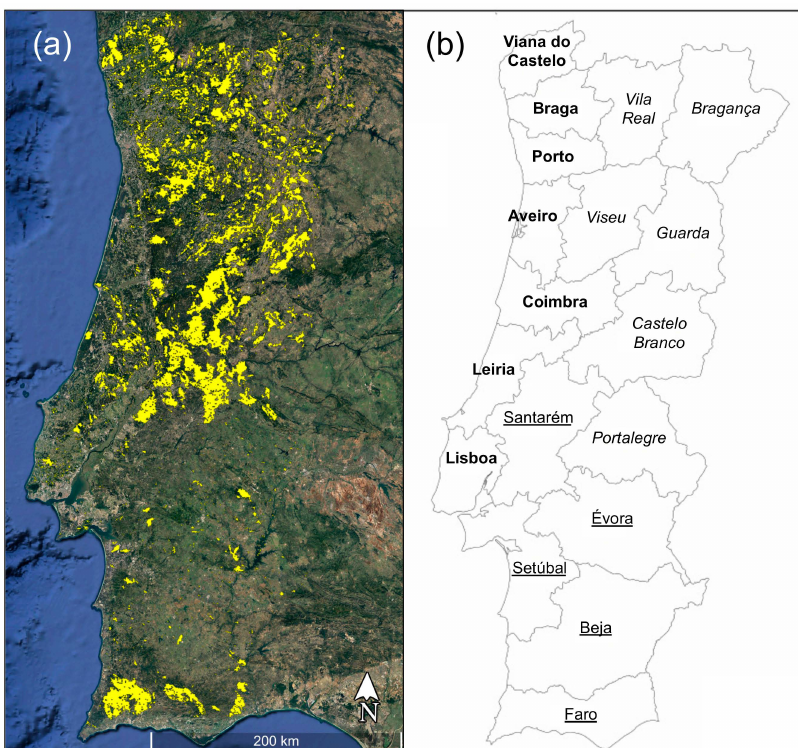
Figure 1. Cumulative burned area in Portugal (2001–2011) overlaid on Google Earth imagery (map data courtesy of © 2018 Google) ( a ) and administrative regions ( distritos ) ( b ). Bold, italic, and underlined lettering indicates regions belonging respectively to the North and Central West (NCW), North and Central East (NCE), and South (S) supra